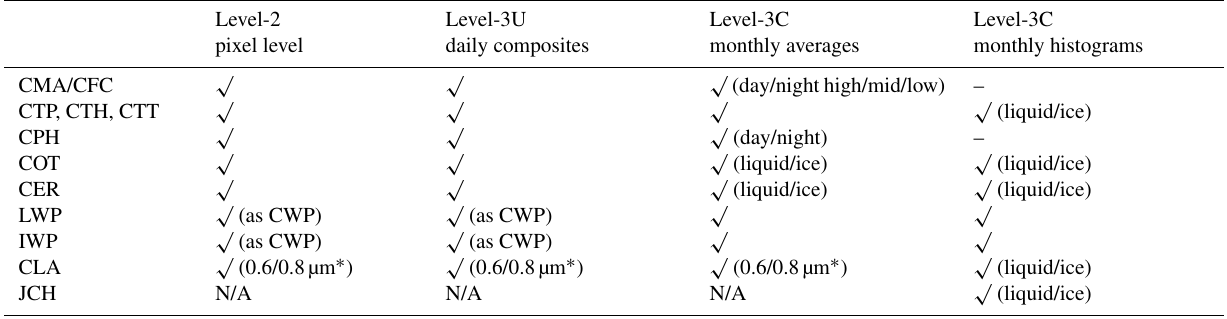
Table 4. Cloud_cci product portfolio, also featuring day/night and liquid/ice separation for some properties. All products listed exist for each dataset.